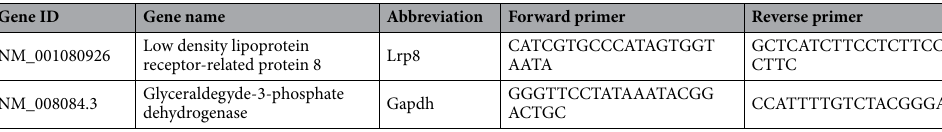
Table 1. Intron spanning mouse oligonucleotide primers used in this